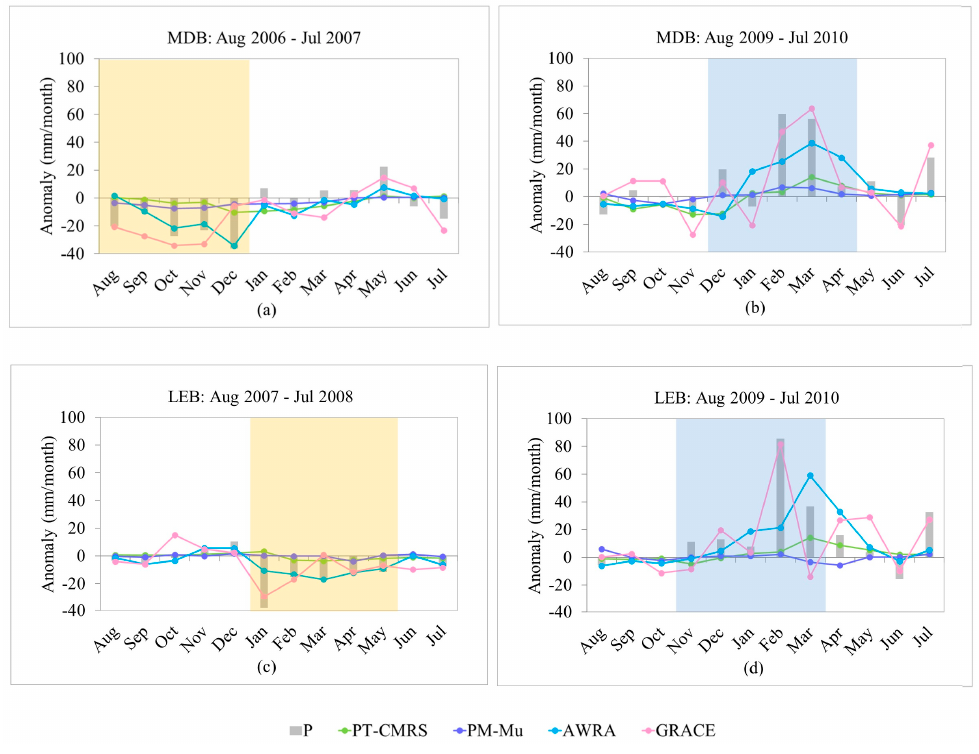
Figure 5. Monthly ET anomalies during extreme climatic events: peak of Millennium drought and La Niña computed as deviation to monthly averages for the whole study period (August 2003 to July 2010). MDB ( a ) and LEB ( c ) during the peak of the Millennium drought; MDB ( b ) and LEB ( d ) during the La Niña period.